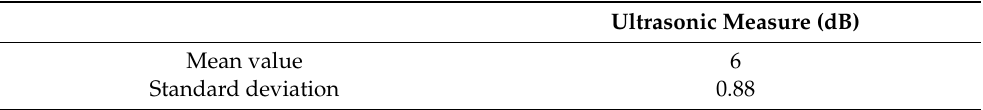
Table 6. Average results of ultrasonic measure for all samples (the complete set of results are available in the Appendix A in Table A4).